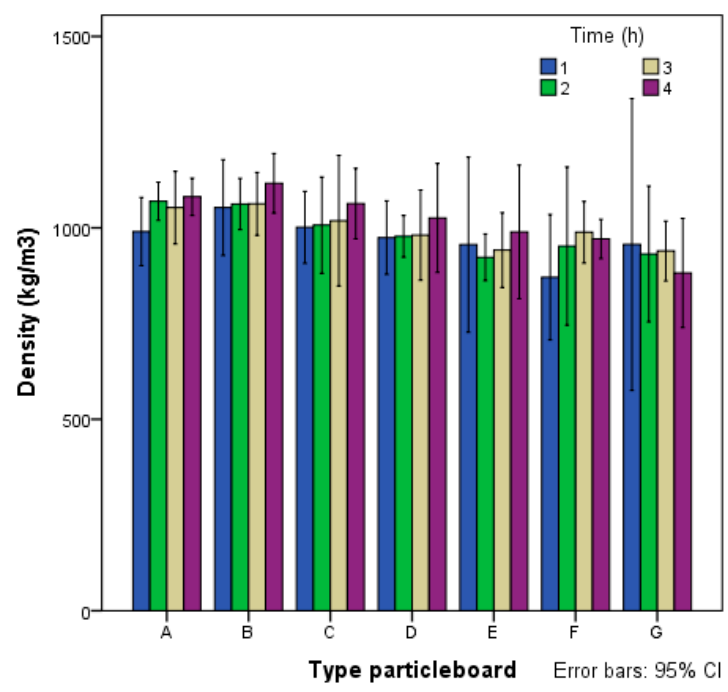
Figure 3. Mean density of type A–G particleboards.